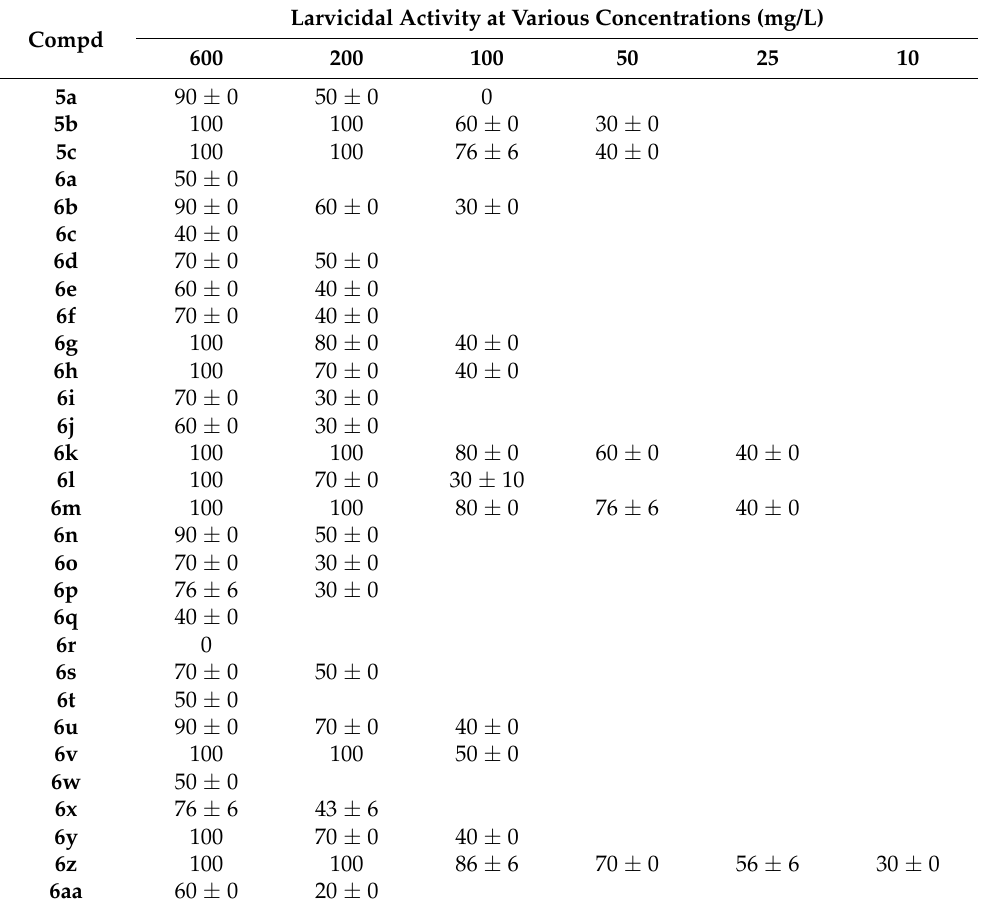
Table 2. Larvicidal activity of compounds 5a − 5c , 6a − 6aa against Plutella xylostella . Larvicidal Activity at Various Concentrations (mg/L) Compd